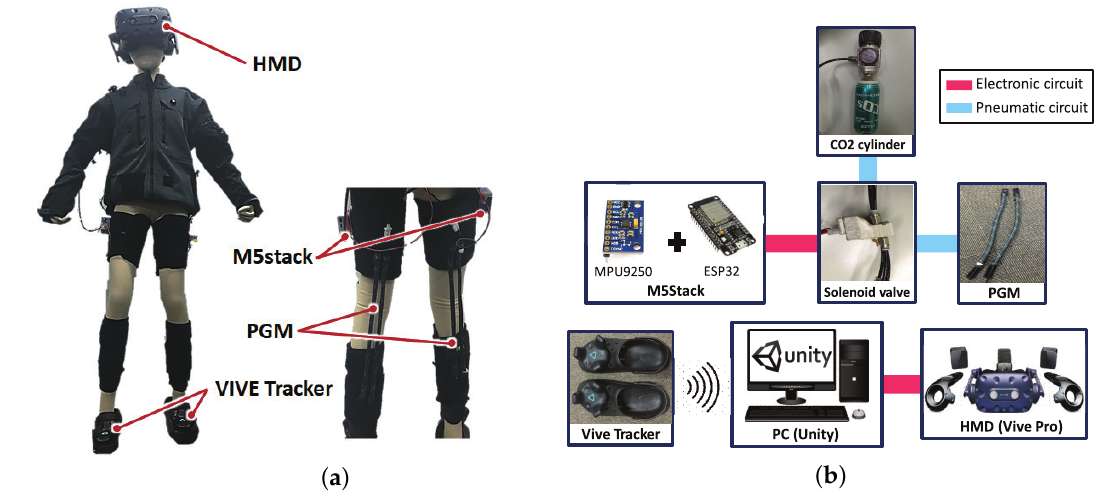
Figure 2. Configuration of the visual and force display parts: ( a ) overview of the force feedback suit and ( b ) details of the constructed system. PGM—pneumatic gel muscle; HMD—head-mounted